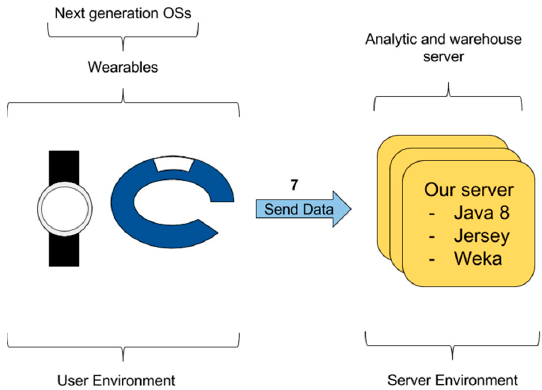
Figure 8. System representation for the wearable data transfer—direct access.